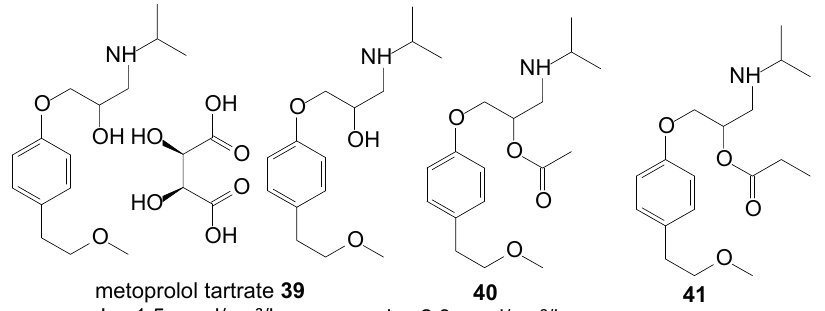
Figure 11. Metoprolol and its ester